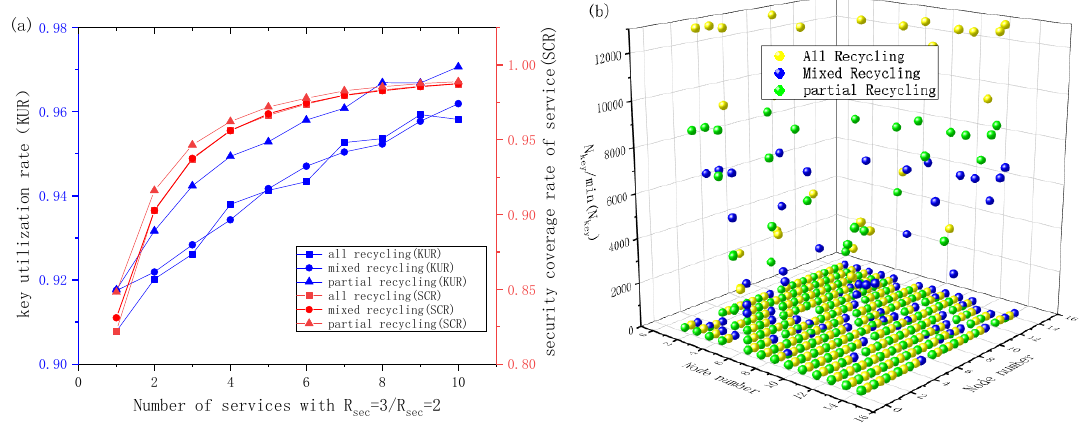
Figure 13. ( a ) The impact of service mix ratios of di ff erent security levels on KUR and SCR of QKD networks with di ff erent QKR mechanisms, when V key_gen is 120, SFR is 30%, and service intensity is 250. ( b ) The number of remaining keys in the key pool of each node after the simulation.